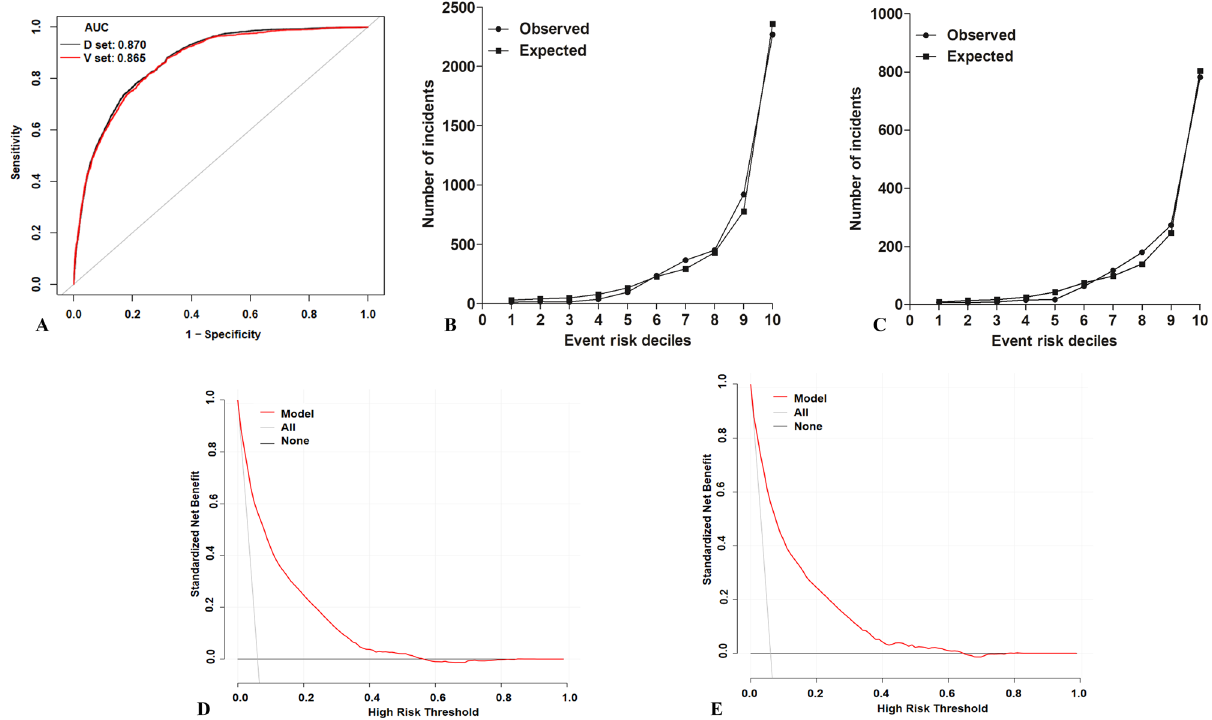
Figure 3. Assessment of a predictive model. ( A ) The receiver operative characteristics curve of the model (D set: derivation cohort; V set: validation cohort). ( B ) The calibration plot of the model in derivation cohort. ( C ) The calibration plot of the model in validation cohort. ( D ) Decision curve analysis for the model in derivation cohort. ( E ) Decision curve analysis for the model in validation